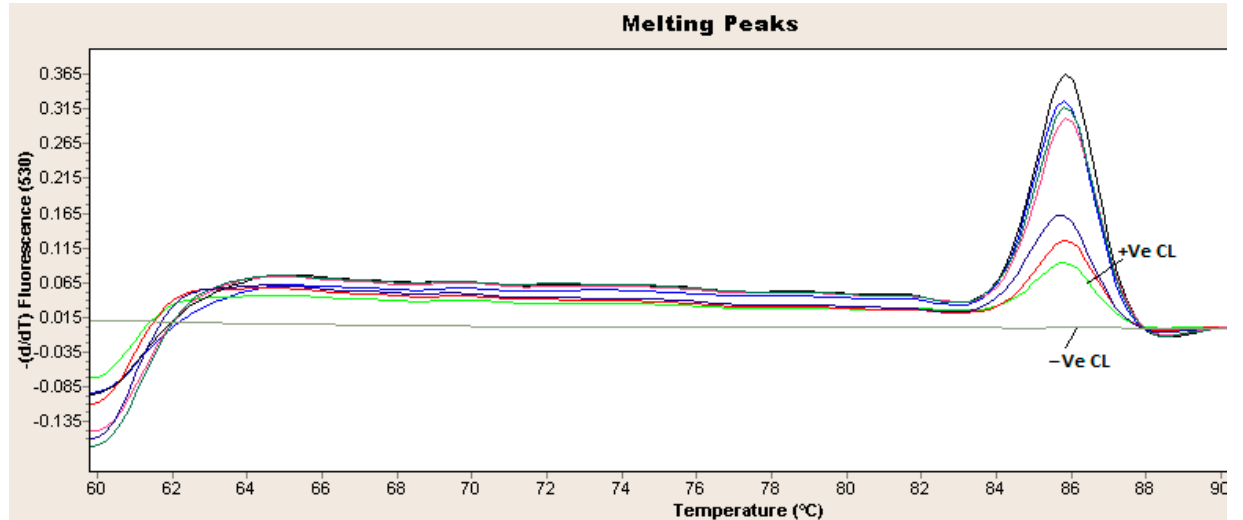
Figure 5. Real-time PCR amplification curves. Melting curve of the amplified FAdV-4 hexon gene from infected chickens tested tissue specimens (heart, spleen, kidney or liver). The arrows indicate positive control (+Ve CL) and negative control ( − Ve CL). The qPCR was performed with LightCycler ® 2.0 Instrument.